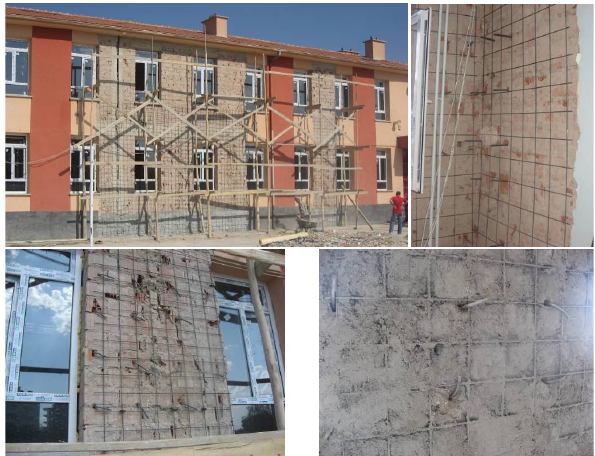
Fig. 18 Welded wire mesh application on a masonry school building Fig. 18. Welded wire mesh application on a masonry school build-